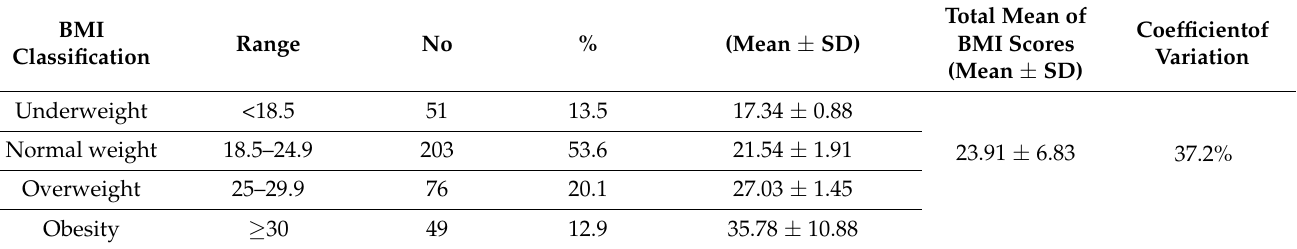
Table 2. Body mass index (BMI) classification among the studied participants (n = 379).